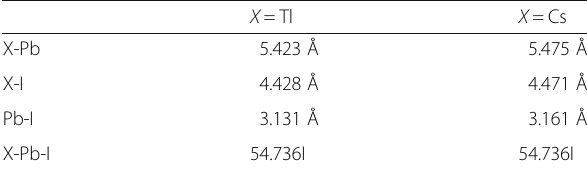
Table 1 The bond distances and bond angels of TlPbI 3 and CsPbI 3